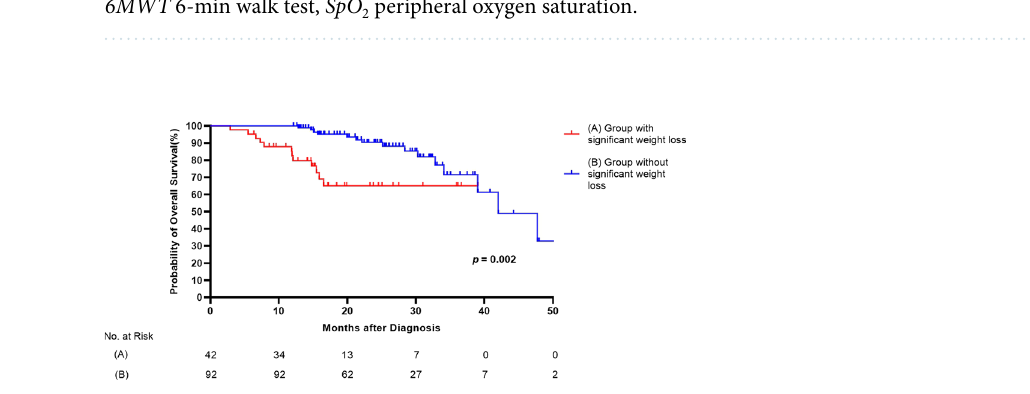
Figure 1. Comparison of survival curves between groups and without significant weight loss among patients with IPF. (A) Group with significant weight loss, (B) Group without significant weight